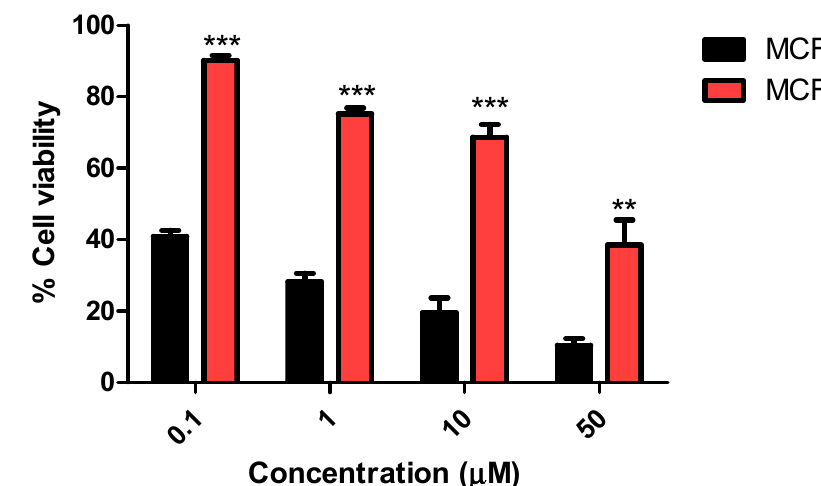
Figure 6. Dose response curve for compound 19h on the proliferation of breast cancer MCF-7 and normal breast MCF-10A cells. Cells were treated at the indicated concentrations for 72 h. Cell viability was expressed as percentage of vehicle control [ethanol 1% ( v / v )] treated cells and was measured by MTT assay (average of three independent experiments). Statistical analysis was performed using one-way ANOVA-Bonferroni post-hoc test (**, p < 0.01; ***, p < 0.001).